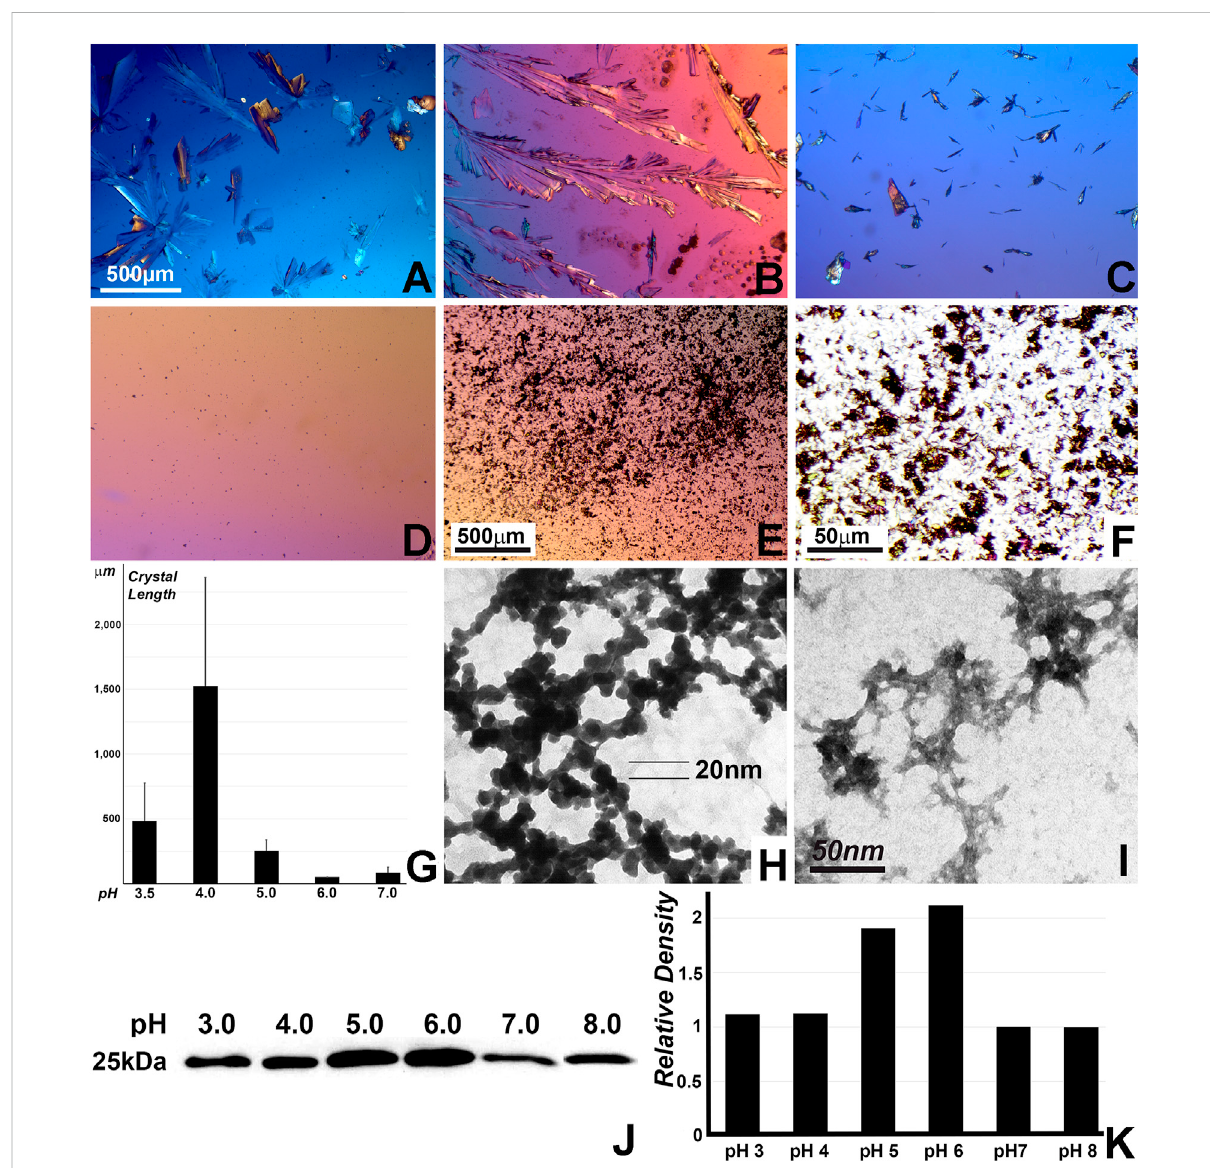
FIGURE 4 Effect of pH on calcium phosphate crystal growth and on the binding of the N-terminal amelogenin N92 to nano-hydroxyapatite. (A – F) Micrographs of calcium phosphate crystals grown on non-coated polystyrene plates at pHvaluesfrom pH3to pH7. (F) is aten-fold enlargedview of (E) illustratingindividualcrystalshapes. (G) Averagecrystallengthcomparisonbasedonthecalciumphosphategrowthstudyonpolystyreneplatesat pH values from pH3 to pH7 as performed in (A – F) . (H,I) Calcium phosphate crystal growth studies on carbon-coated TEM grids without the presence of protein. (H) calcium phosphate crystal growth at pH four and (I) calcium phosphate crystal growth at pH 7. The 50 nm scale bar in (I) is provided as a reference for both electron micrographs. (J) Nano-hydroxyapatite binding to N92 N-terminal amelogenin. For this